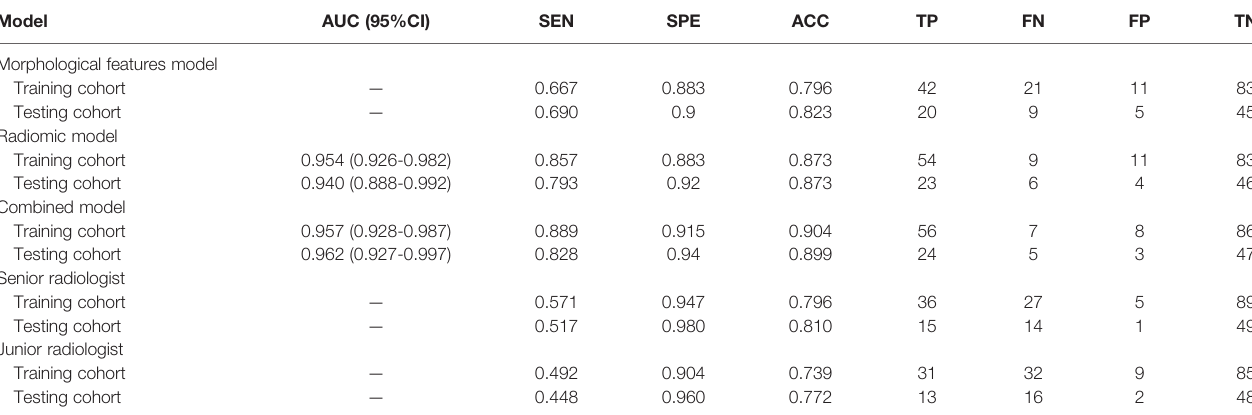
TABLE 3 | The Performance of Models in Training and Testing cohorts.